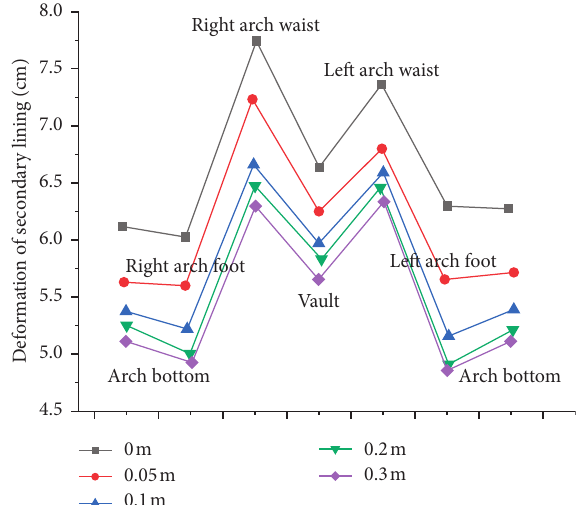
Figure 9: Deformation of the second liner under the action of different grouting thicknesses.